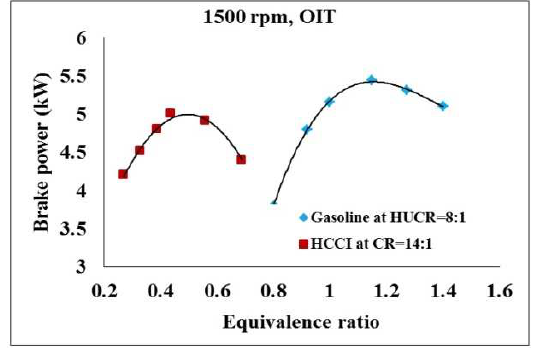
Fig. 6. The bsfc for variable bp of the two systems at HUCR for each one.